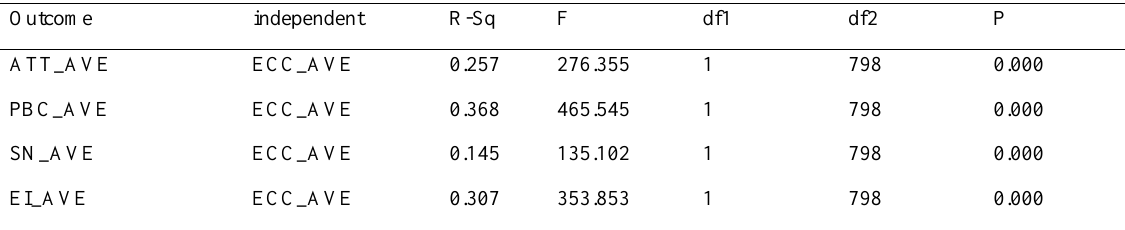
Table 4: Model Adequacy Summaries for direct effects of ECC on Mediating Variables